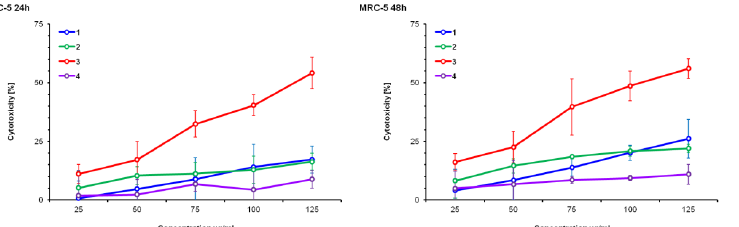
Figure 3. Cytotoxicity percentage determined by MTT test on MRC-5, after 24 h and 48 h exposures to V. vinifera extracts in a concentration ranging from 25 μg/mL to 125 μg/mL. (1) Dry extract — DE; (2) subcritical water extract — SWE; (3) resveratrol — RSV; (4) maltodextrin — M. (2) subcritical water extract—SWE; (3) resveratrol—RSV; (4) maltodextrin—M. Table 1. IC 50 values obtained by MTT test, after 24 h/48 h treatments of HeLa, MCF-7 and MRC-5 cells with dry extract, subcritical water extract, resveratrol and maltodextrin.